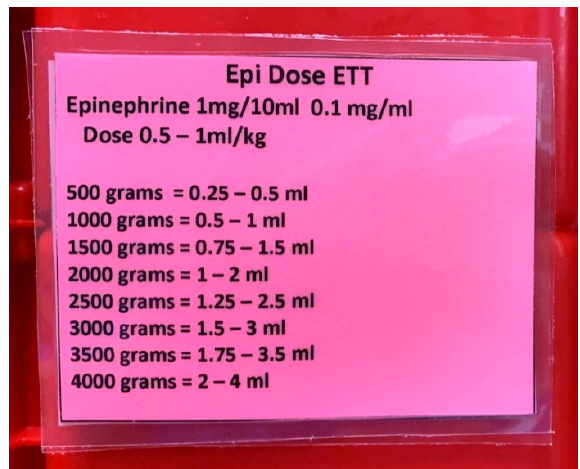
Figure 2. Epinephrine Administration via Endotracheal Tube Dosing Card Inside the Tackle Box.